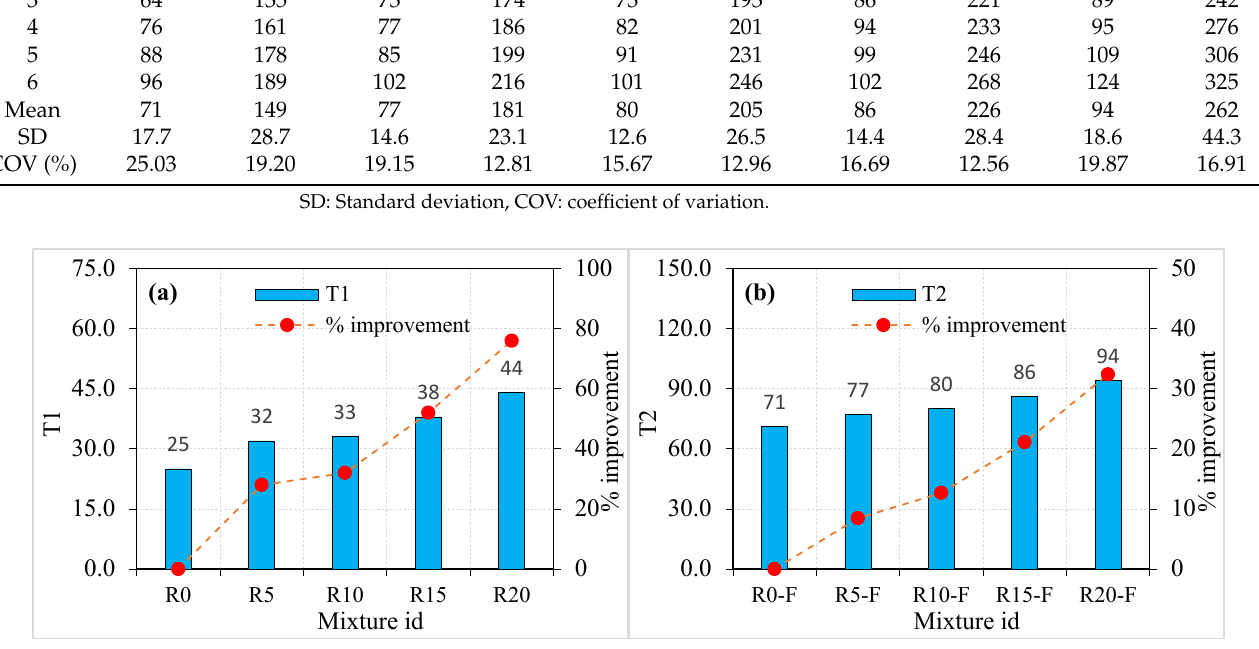
Figure 6. Impact strength of non-fibrous specimen ( a ) T1 and ( b ) T2.